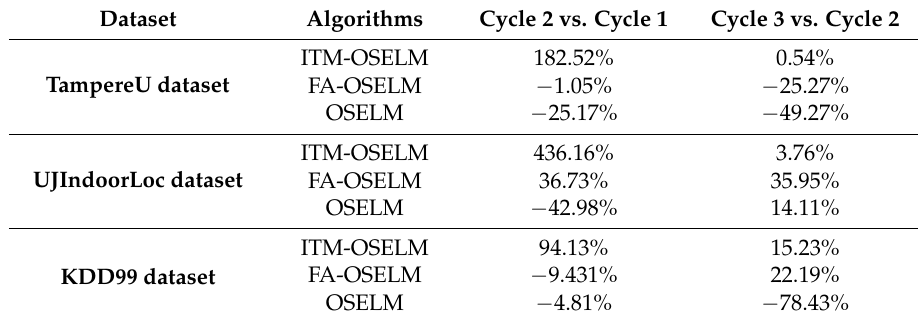
Table 3. Learning improvement percentage of the three models with respect to cycles, percentage of the three models with respect to